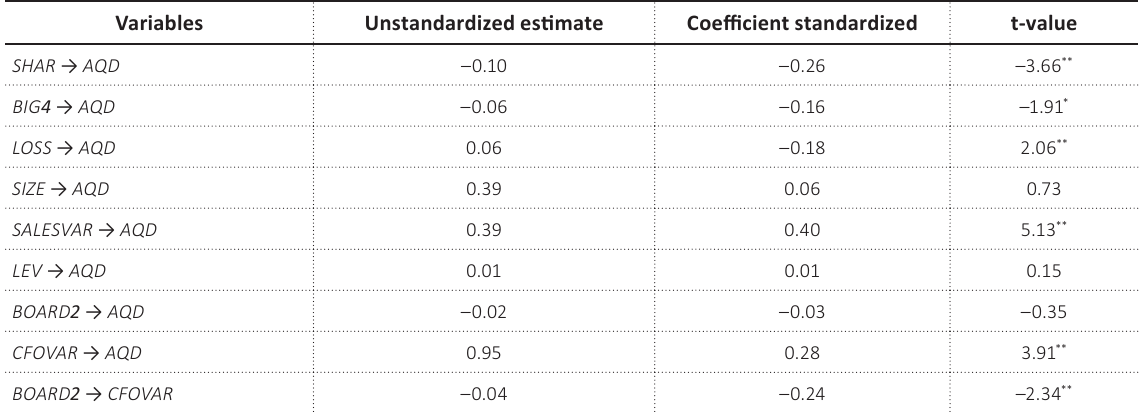
Source: Data processed with LISREL.